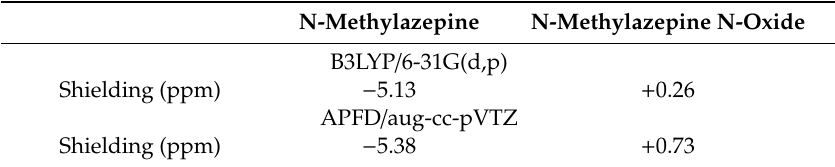
Table 12. Calculated NICS(0) values at two levels. A significant positive value (e.g., > 5.0) connotes significant aromaticity. Significant negative values connote antiaromaticity.